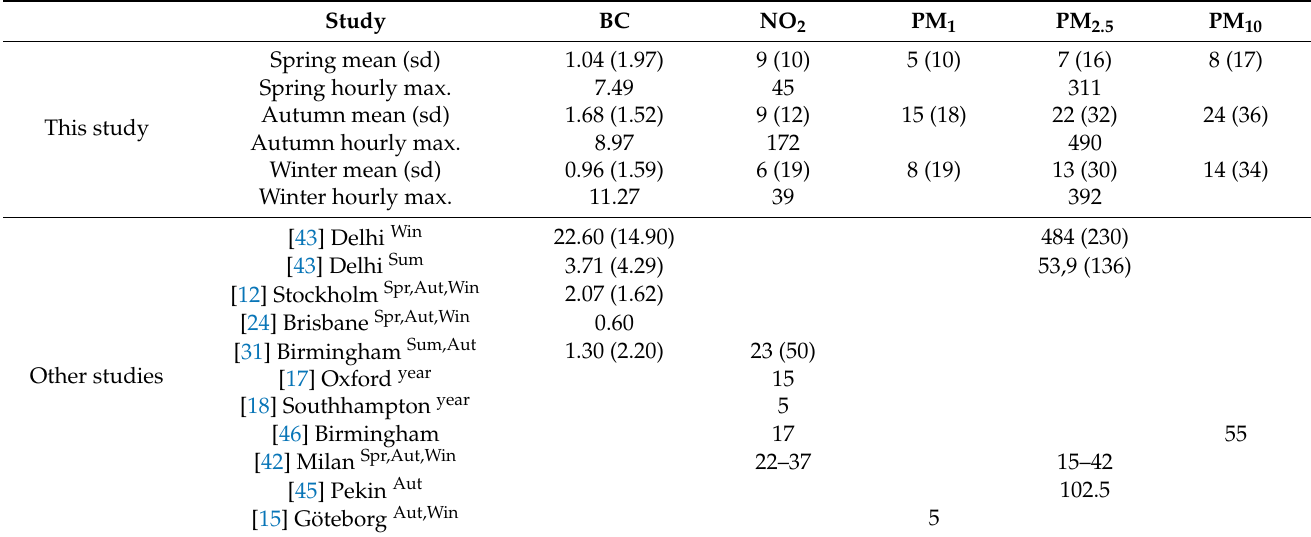
Table 2. Mean measured exposure and standard deviation (sd) in different studies (BC in µ g · m − 3 , NO 2 in ppb and PM in µ g · m − 3